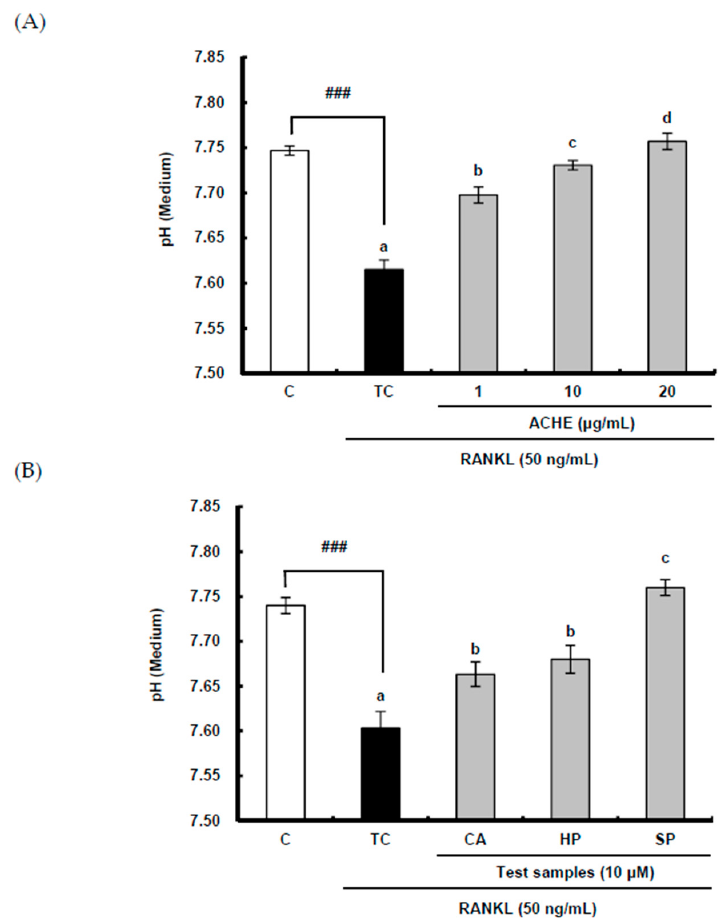
Figure 5. ( A ) Inhibitory effect of hydroethanolic extract of A. capillaris and ( B ) three bioactive compounds on acidification. RAW 264.7 cells were exposed to RANKL (50 ng/mL) for 5 days in the absence and presence of ACHE. After 5 days, the pH of the differentiated medium was measured using a pH meter. Data are expressed as percentages of the values of untreated cells (means ± standard deviations, n = 3). Different corresponding letters indicate significant differences at p < 0.05 by Duncan’s test. ## p < 0.01, ### p < 0.01 vs. C. C: control, which was not treated; TC: treated control, which was treated with RANKL; CA: chlorogenic acid; HP: hyperoside; SP: scoparone.